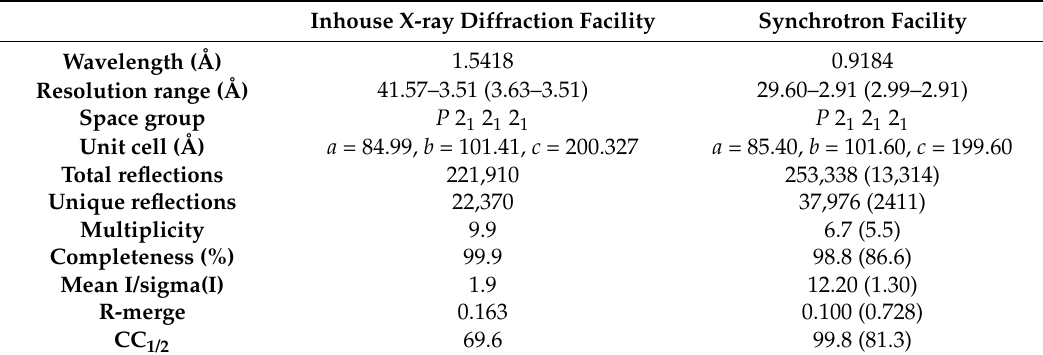
Table 3. Apo-transferrin: Data collection and X-ray statistics.